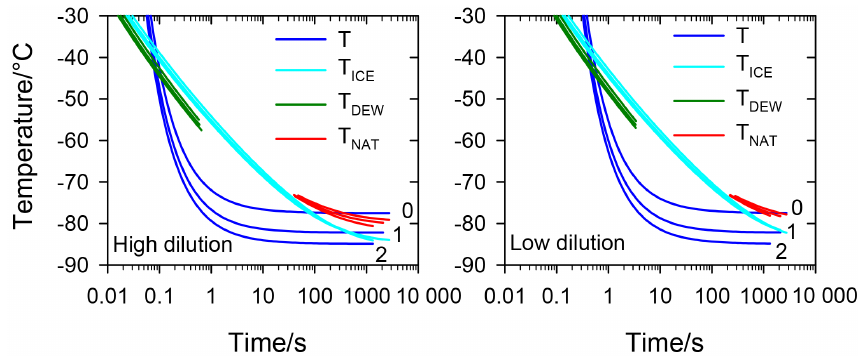
Figure 17. Air temperature T , frost-point T ICE , dew point temperature T DEW , and nitric acid trihydrate existence temperature T NAT in the exhaust plumes (0: invisible plume, 1: upper contrail, 2: lower contrail) for high (left) and low (right) dilution. T DEW is shown up to the point of maximum liquid saturation (LM in Fig. 16), T NAT is shown for T <200K, i.e. in the validity range of the relation given by Hanson and Mauersberger